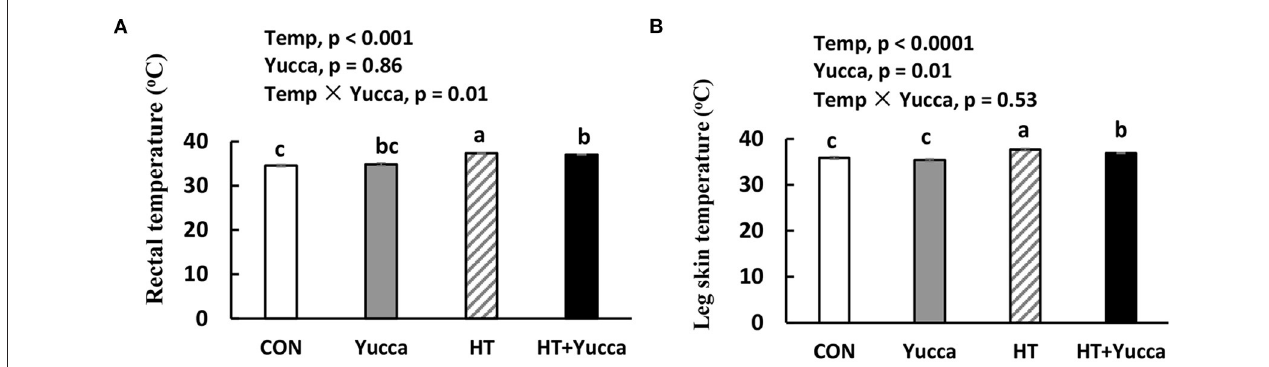
FIGURE 1 | Rectal temperature (A) and leg skin temperature (B) in broilers at 56 days. Broilers, of 28 days of age, were fed a basal diet and exposed to 24 ◦ C (CON) or 34 ◦ C (HT), or a basal diet supplemented with 0.1% yucca and exposed to 24 ◦ C (Yucca) or 34 ◦ C (HT + Yucca) for 4 wks. Values are means ± SE, n = 6. Means without a common letter differ ( P <